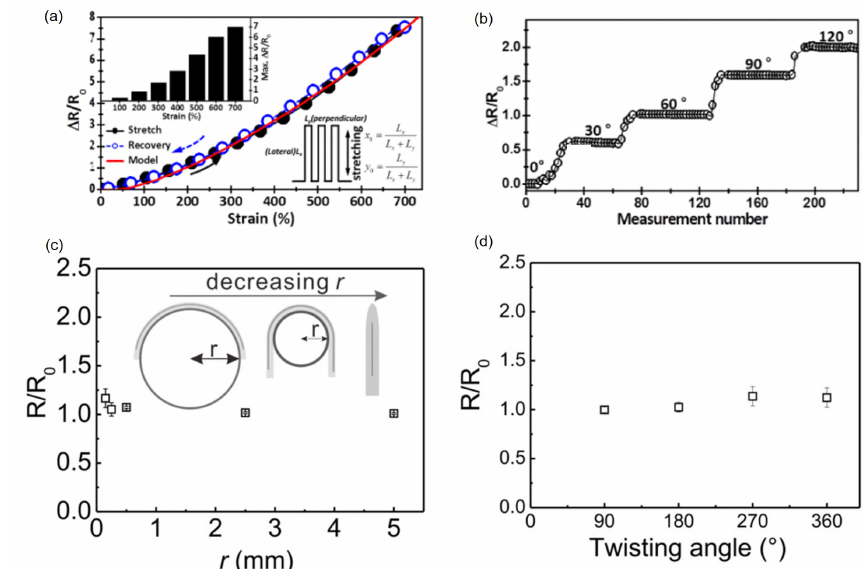
Figure 9. ( a ) Normalized resistance change of the liquid metal strain gauge during the uniaxial stretching test from (cid:101) = 0 to (cid:101) = 700%. Measurement is in good agreement with model. © [2015] IEEE. Reprinted, with permission, from [50]. ( b ) Normalized resistance change of the liquid metal strain gauge during the bending test from 0 ◦ to 120 ◦ © [2015] IEEE. Reprinted, with permission, from [50]. ( c ) Normalized resistance as a function of the bending radius from 0.15 to 5 mm and ( d ) normalized resistance as a function of the twisting angle from 90 ◦ to 360 ◦ for a resistive liquid metal device encapsulated with PVA at room temperature. Reproduced with permission from [71]; published by John Wiley and Sons, 2019.